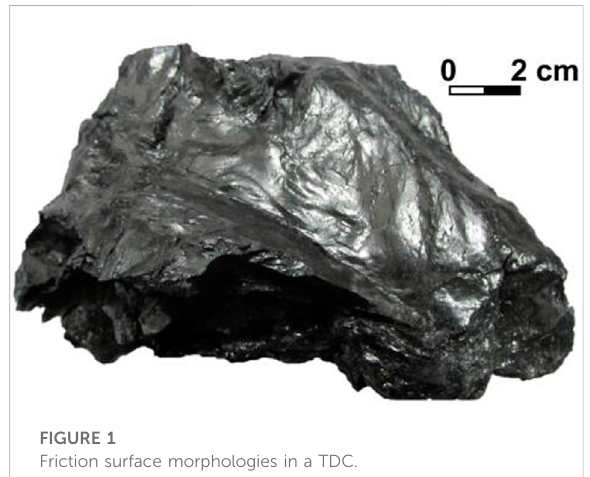
Friction surface morphologies in a